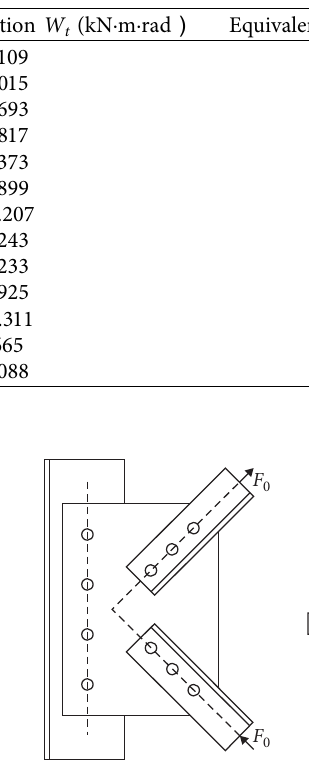
Table 3: Energy consumption index of the K -joint.